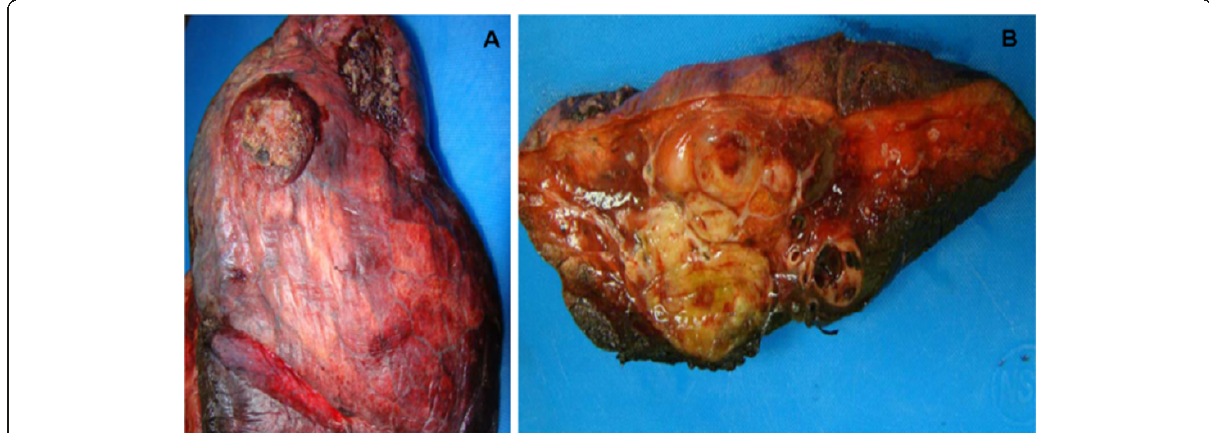
Figure 2 Pulmonary artery angiosarcoma. A . Tumor abutting the pleural surface. B . Right pneumonectomy showing intraparenchymal masses and near total right pulmonary